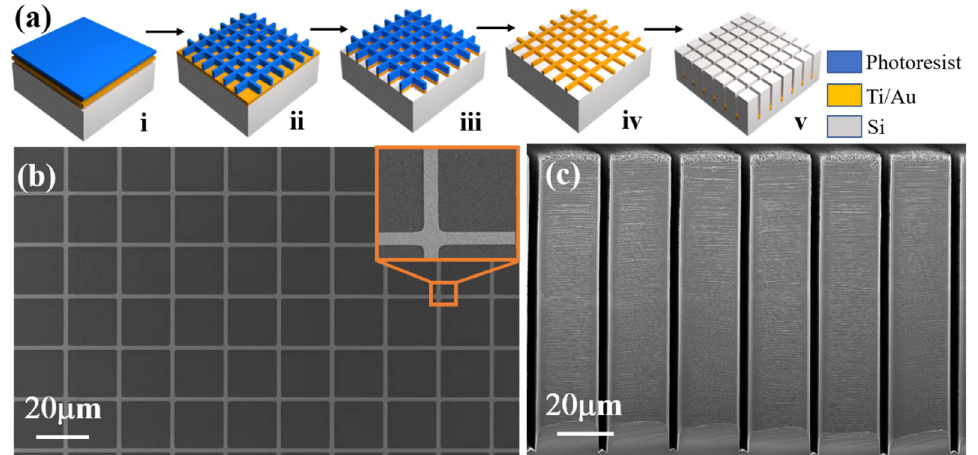
Figure 1. ( a ) Schematics of the fabrication process of ultra-high aspect ratio Si microstructures. ( b ) SEM images of the top micropillar arrays before MacEtch process. ( c ) Cross-sectional SEM images of high aspect ratio Si micropillars with sidewall roughness.